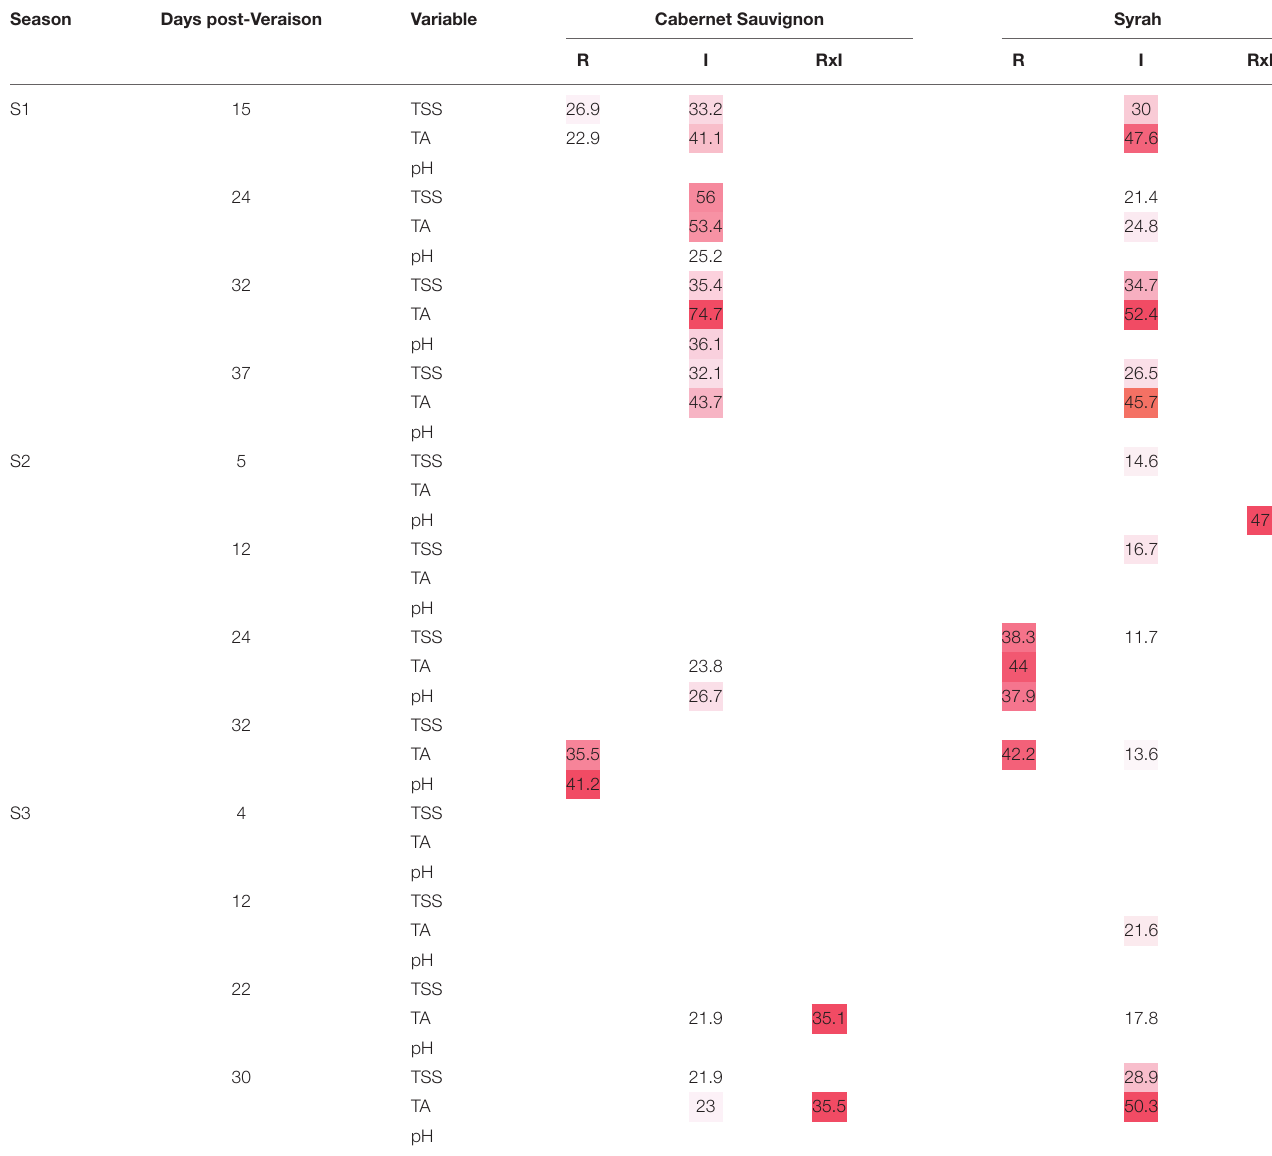
TABLE 4 | Percent of variance explained by each factor (Rootstock and Irrigation) and the interaction (RxI) for the maturity variables in each cultivar and season.